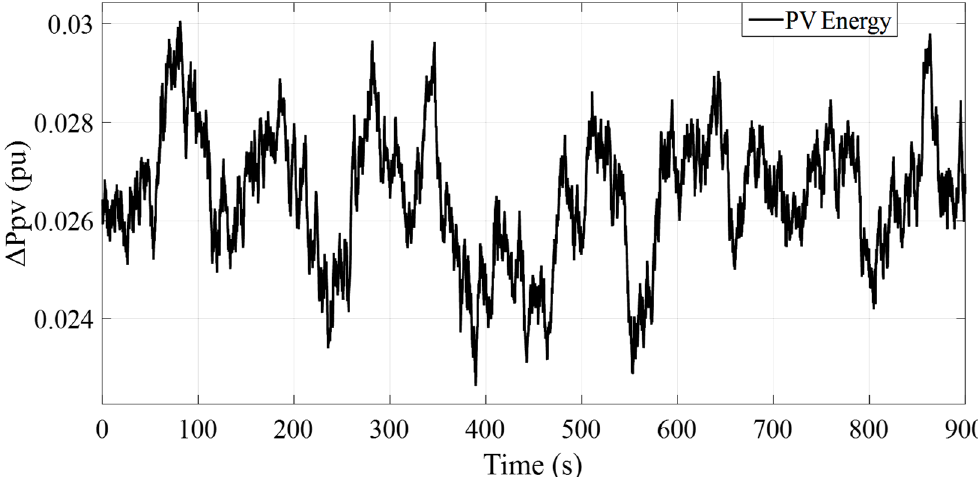
Figure 6. The output PV power.